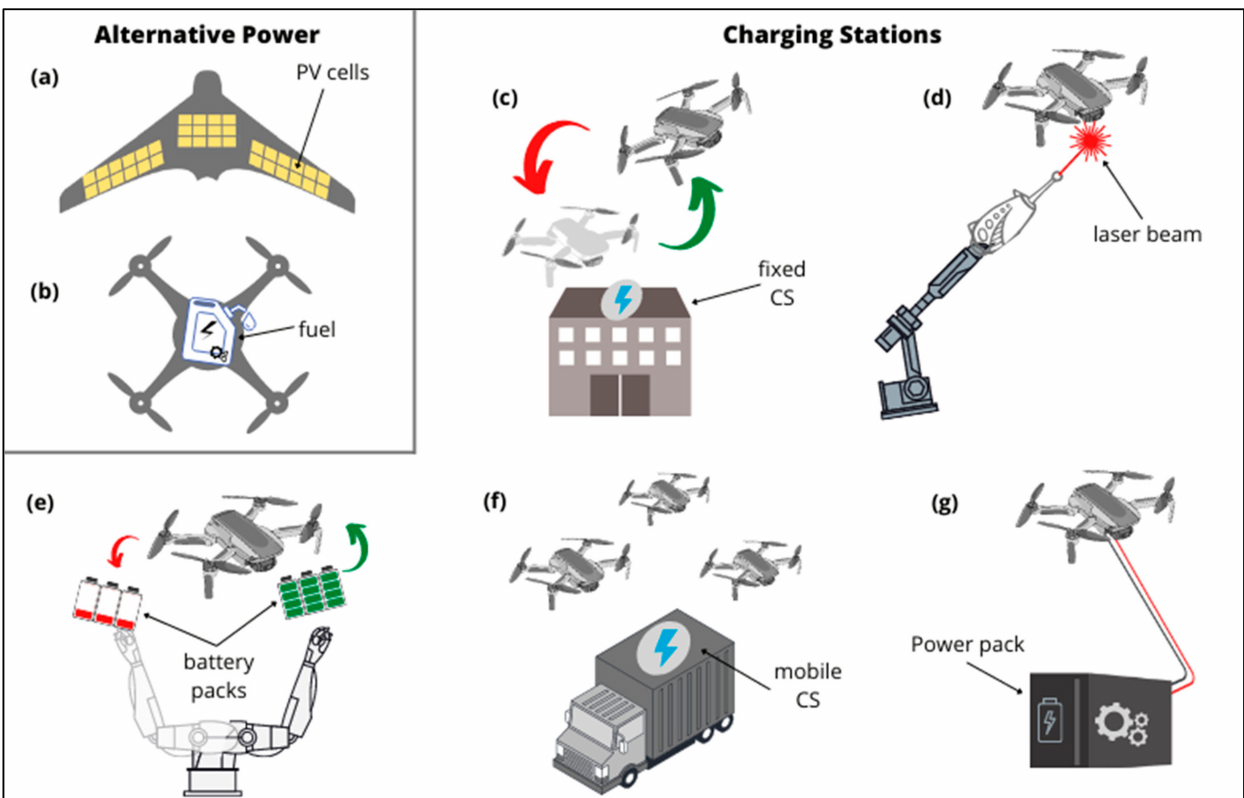
Figure 1. Drone power management. ( a ) Solar-powered drones, suitable for fixed-wing UAVs. ( b ) Hybrid-powered drones, combining energy from electric and fuel cells. ( c ) Drone-swapping method, with a fixed charging station. ( d ) Laser-powered on-the-air recharging. ( e ) Battery hot-swapping, without powering down the drone. ( f ) Mobile recharging stations, with programmed charging scheduling, and ( g ) Tethered